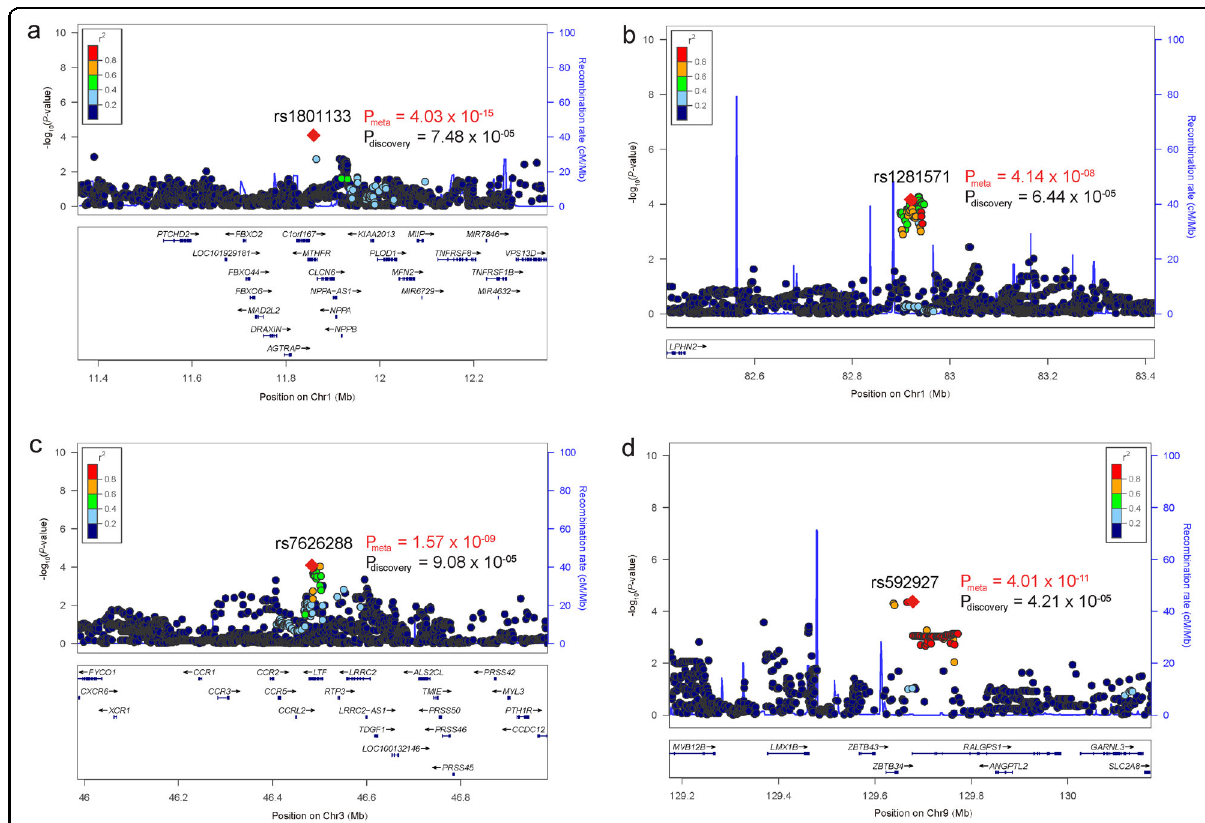
Fig. 2 Locuszoom plots of the genome-wide signi fi cant (LD independent) risk variants. a rs1801133 is located in the fi fth exon of MTHFR . b rs1281571 is located in the downstream of LPHN2 . c rs7626288 is located in the intron 12 of LTF . d rs592927 is located in the upstream of RALGPS1